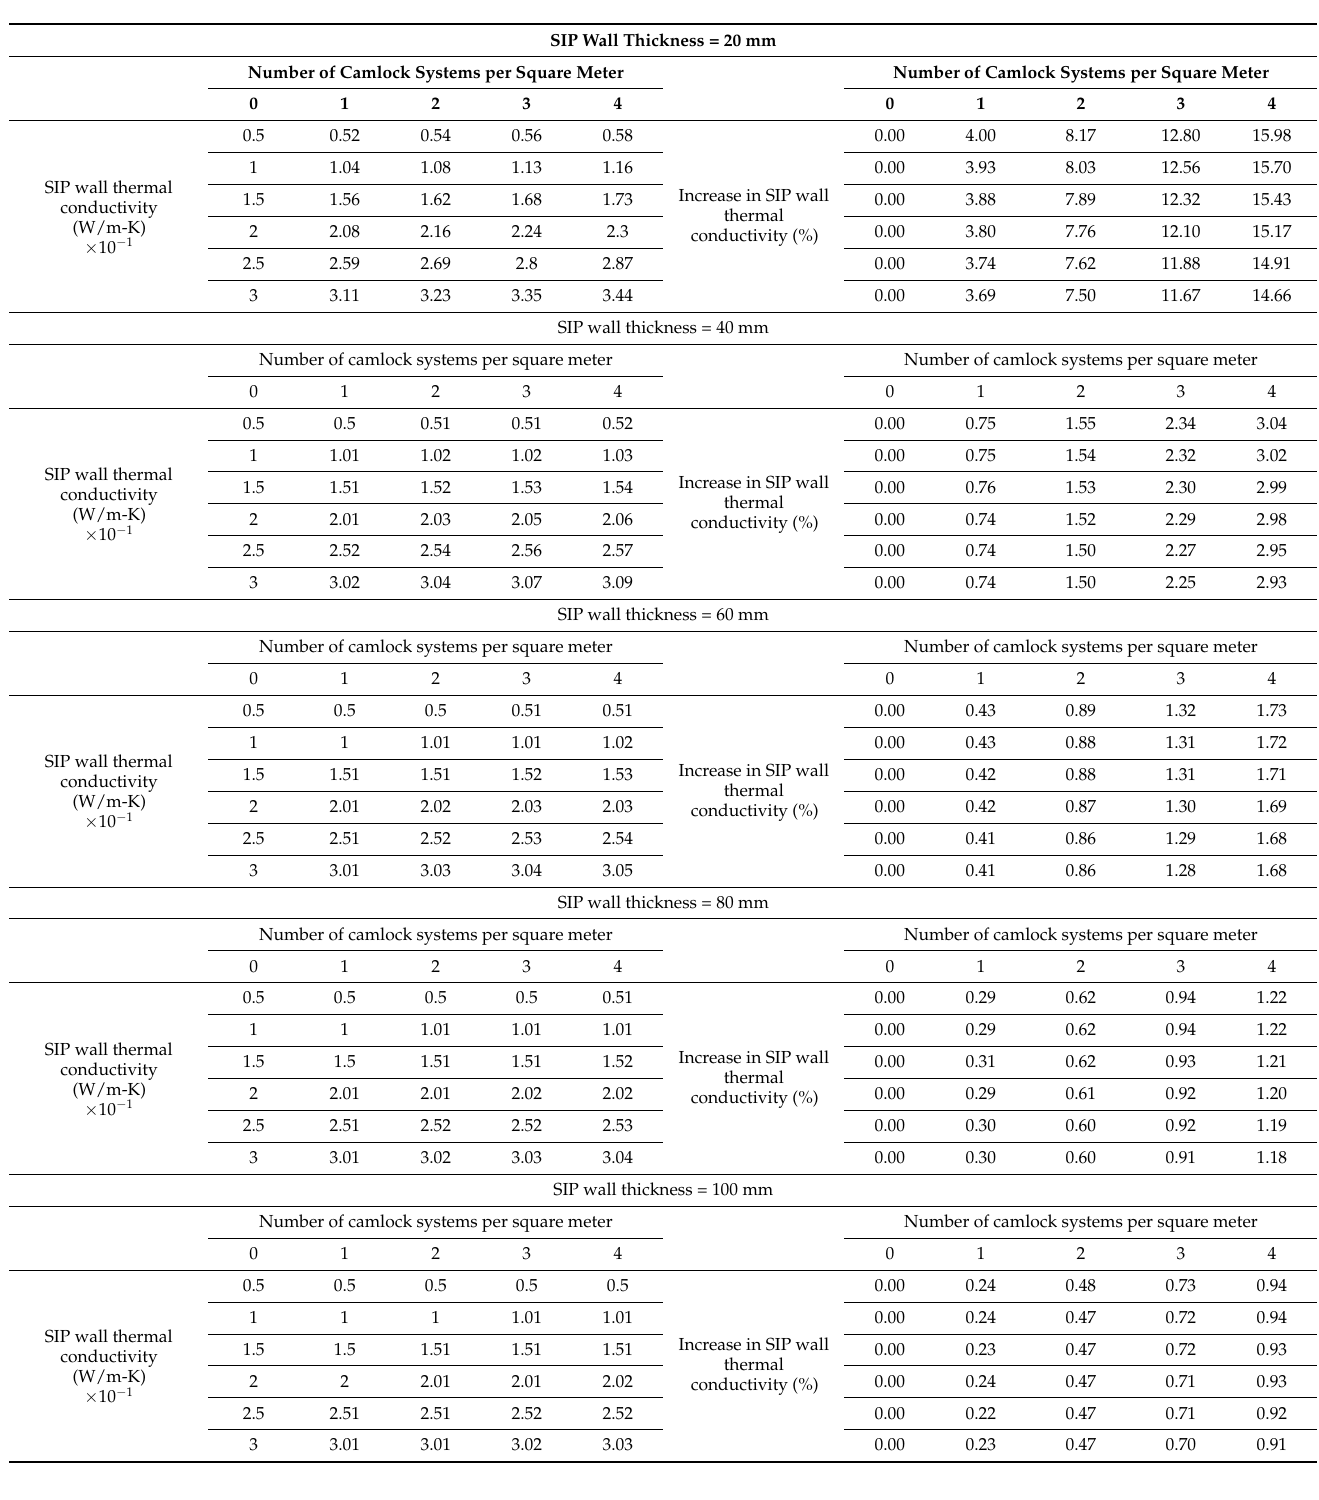
Table 5. Percentage change in the thermal conductivity of the SIP wall with different densities of camlock systems, SIP thermal conductivities, and wall